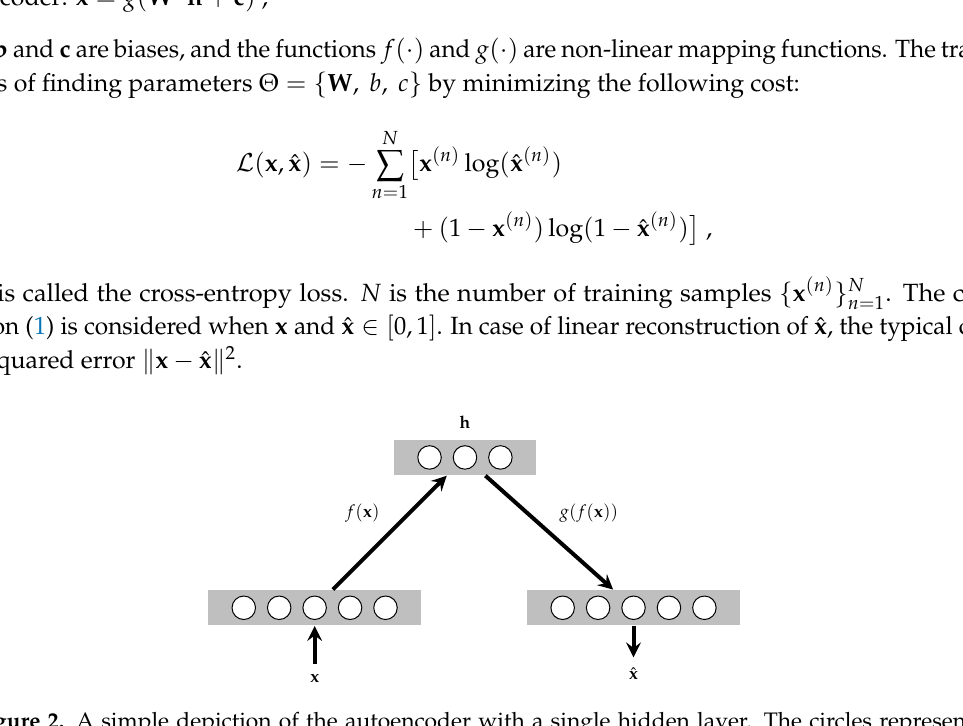
Figure 2. A simple depiction of the autoencoder with a single hidden layer. The circles represent neurons, and the gray region depicts the layer. The hidden layer size is smaller than the input and output layer sizes. This represents the under-complete case in autoencoders that helps to learn a compressed representation. This type of autoencoder is similar to the non-linear principal component analysis